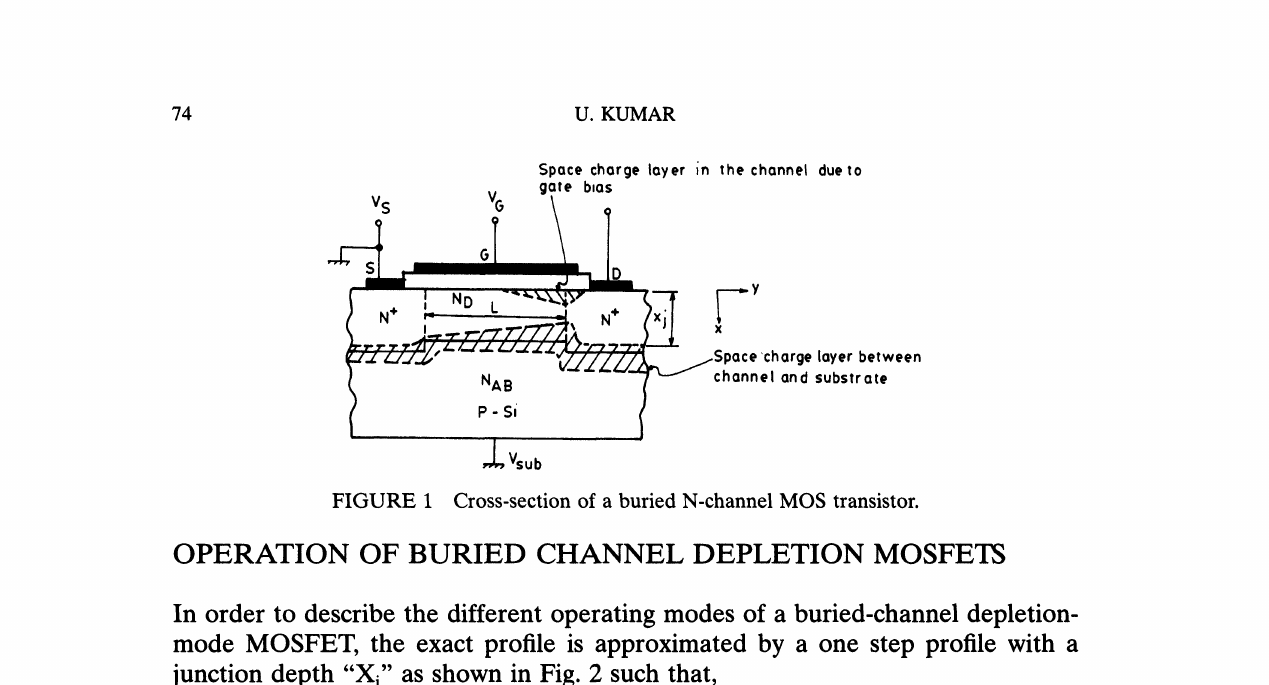
FIGURE 1 Cross-section of a buried N-channel MOS transistor.